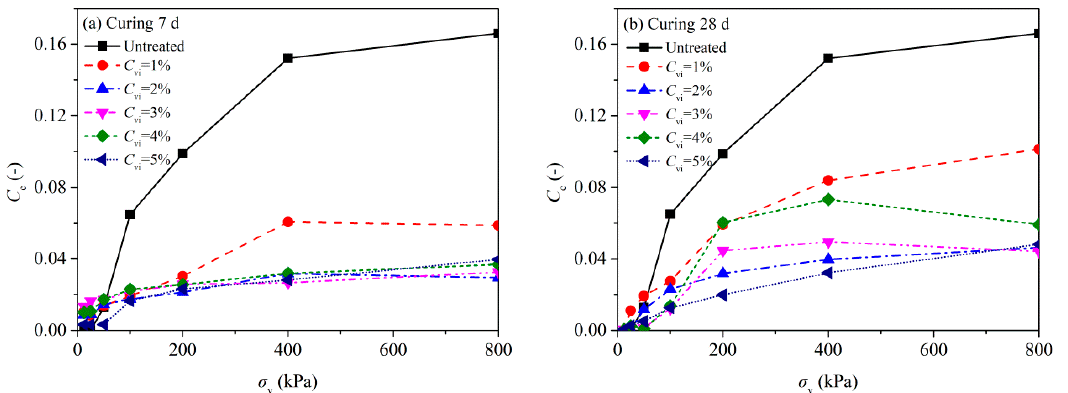
Figure 20. Compression index of saturated untreated and cement-treated GRSs depending on vertical pressure. ( a ) Curing time = 7 d; ( b ) Curing time = 28 d.